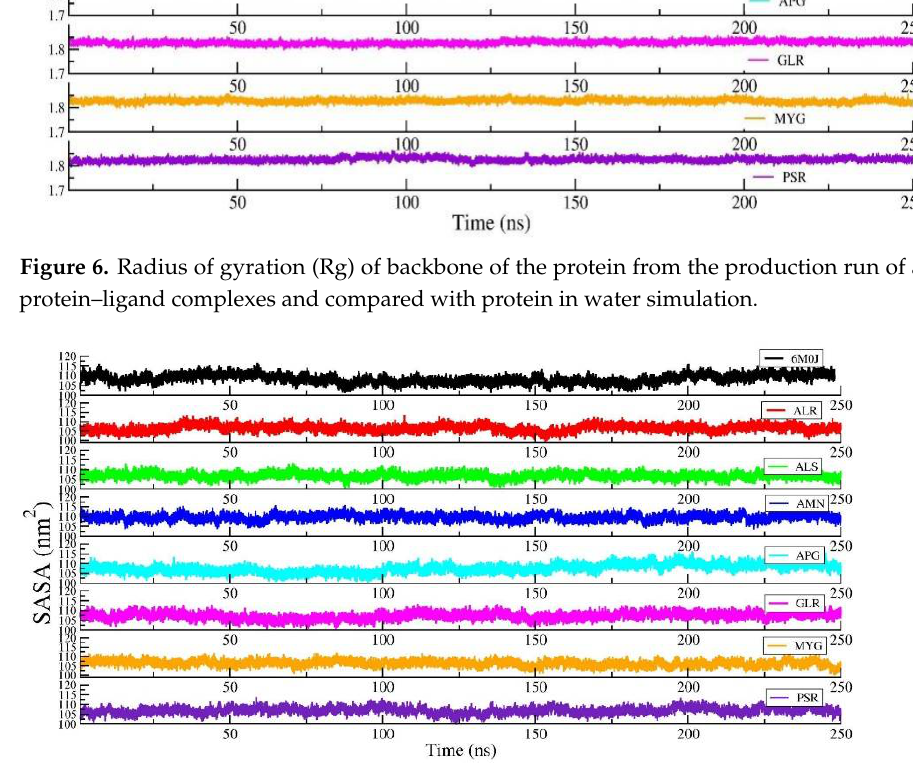
Figure 7. The SASA of the protein in the protein–ligand complex and compared with the protein– water system.